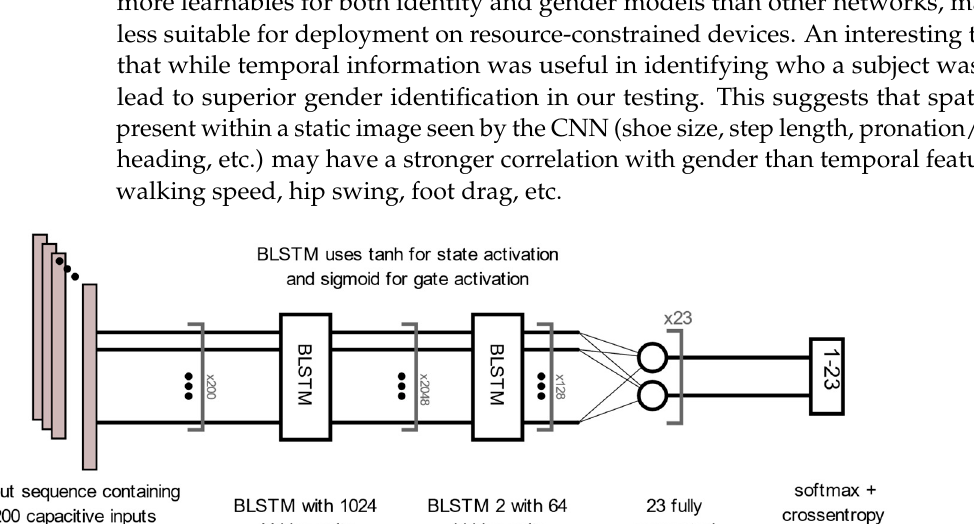
Figure 8. Best Performing Gender Classification Structure: CNN.